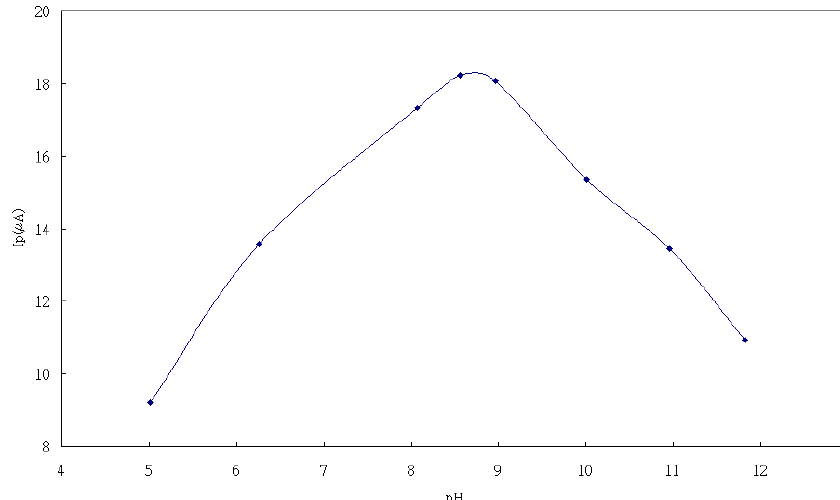
Figure 3. The effect of pH on the response current of 6.22 × 10 − 4 M coumarin in Britton-Robinson (BR) buffer at a thin-film mercury modified GCE (Hg/GCE); differential pulse voltammetry (DPV) scan rate: 10